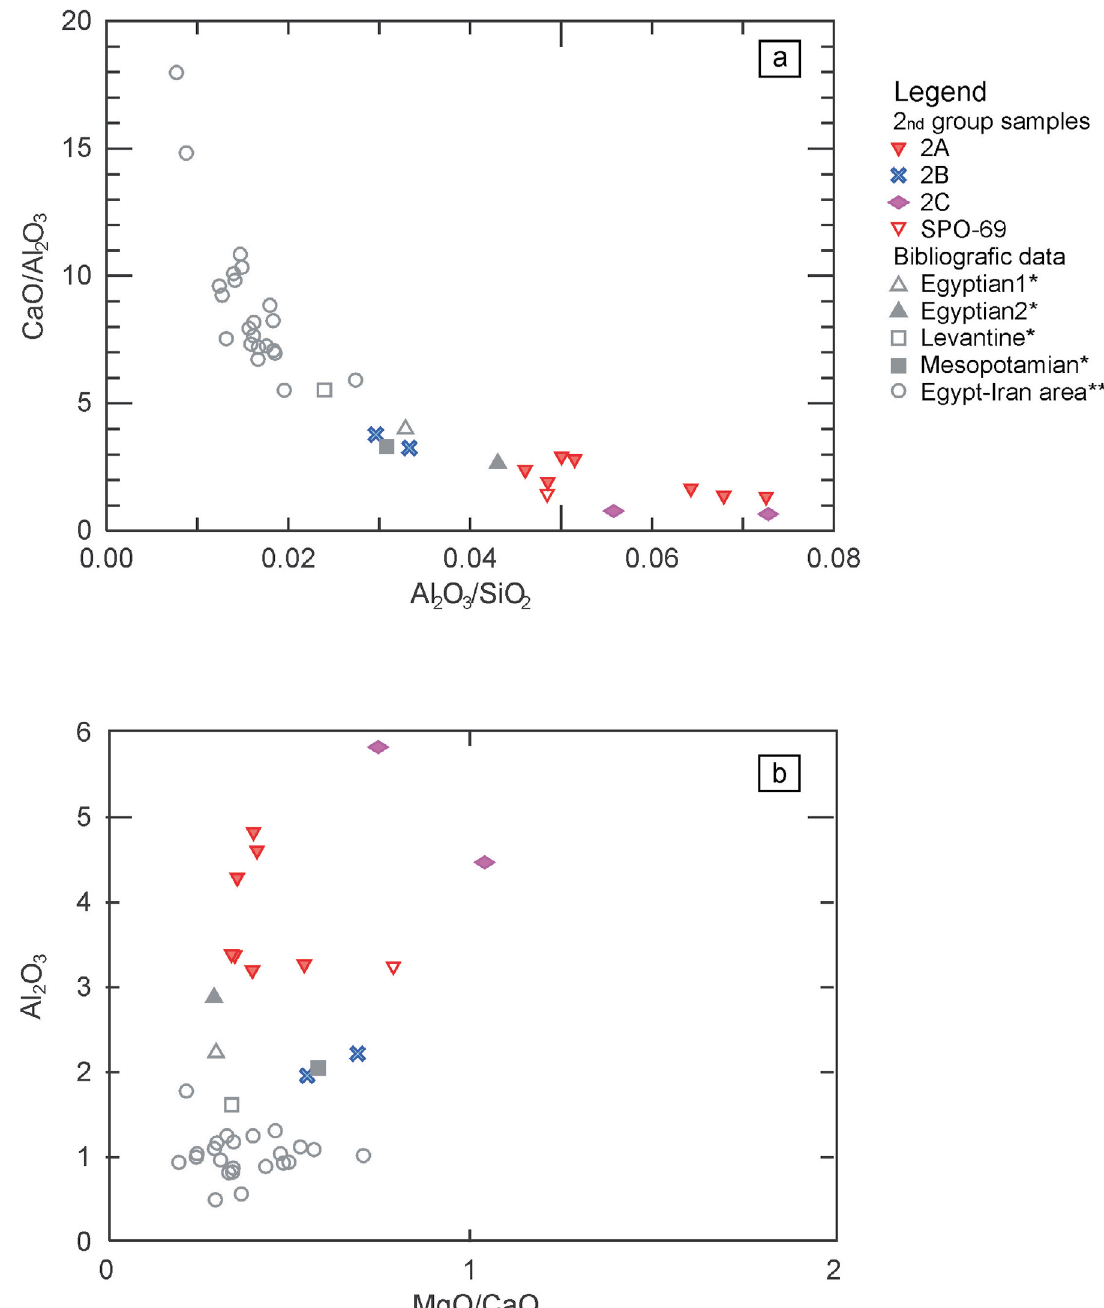
O /SiO vs. CaO/Al O ; b) MgO/CaO vs. Al O binary plots. The samples of the second group have been compa- Figure 8 : a) Al 2 3 2 2 3 2 3 red with the bibliographc data: *Schibille et al., 2019; ** Henderson et al., 2004 (glasses collected in the Islamic site of Tell Fukhkhar, Jordan 11 th century AD); Henderson et al., 2016 (glasses deriving from urban centres in the area between Egypt and Syria dating between 9 th to 14 th century